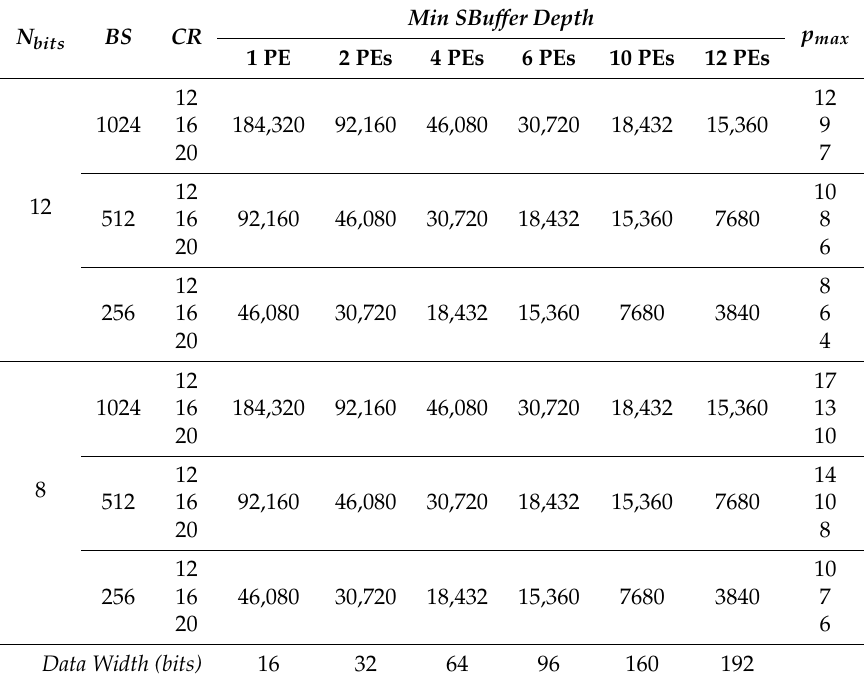
Table 3. Design-time configurations parameters of the HyperLCA transform hardware block for hyperspectral images with 180